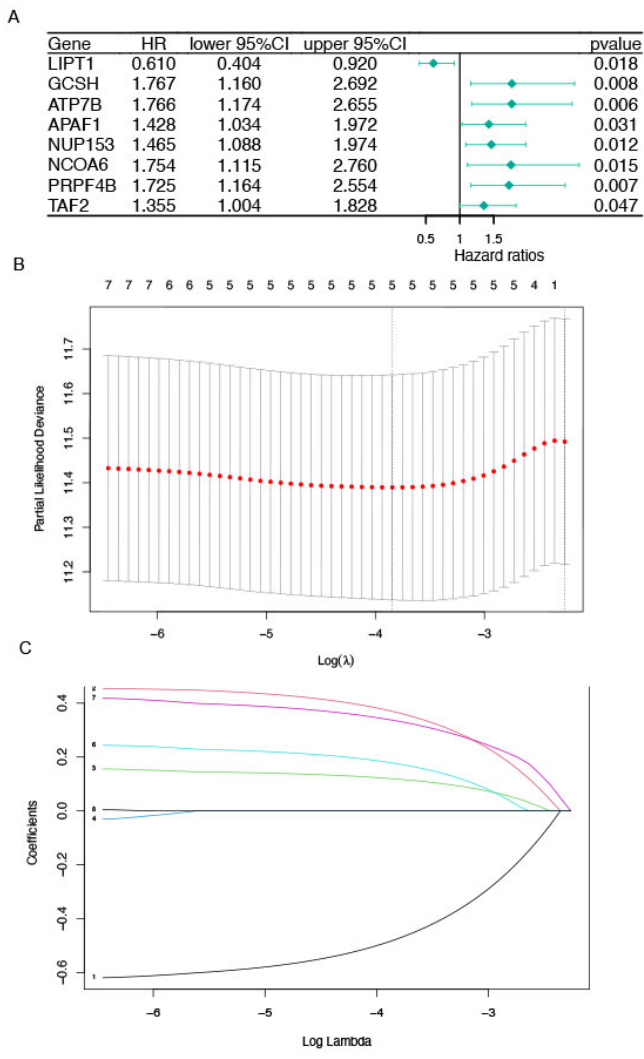
Figure 2. Construction and validation of prognosis-associated genes model of STS using LASSO regression. ( A ) The result of cox regression analysis of prognostic genes for patients with sarcoma. ( B , C ) the results of LASSO regression model.